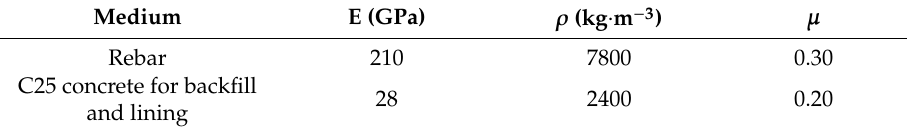
Table 4. Parameter selections of the rock mass in the finite element model. Table 5. The medium parameters in the finite element physical and mechanical models.